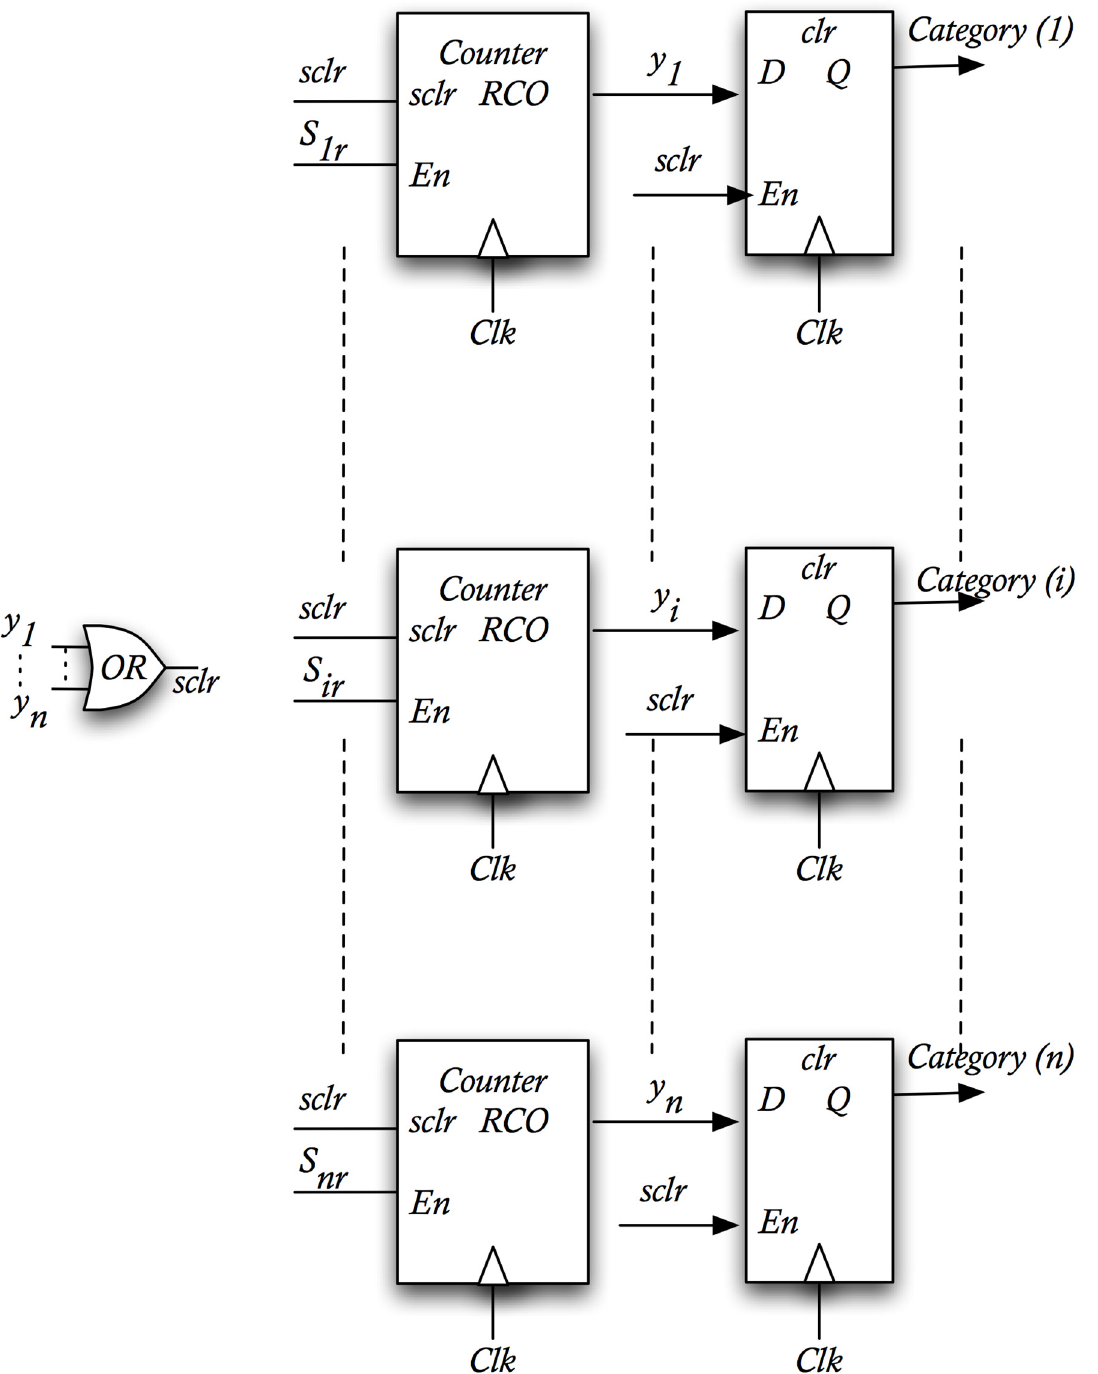
Fig 9. Winner-Take All. Architecture used to select the category associated to the s ir with the higher